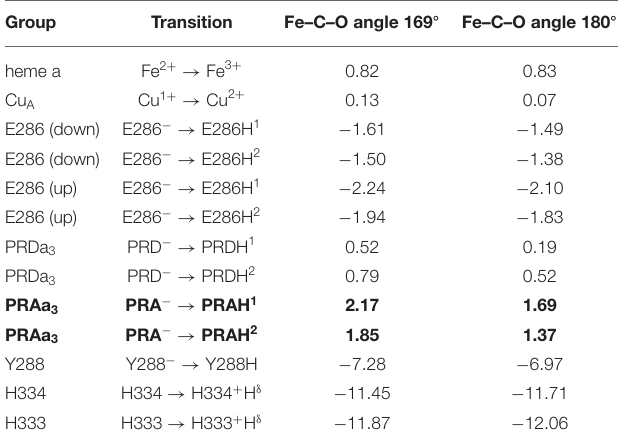
TABLE 1 | Electrostatics computations.